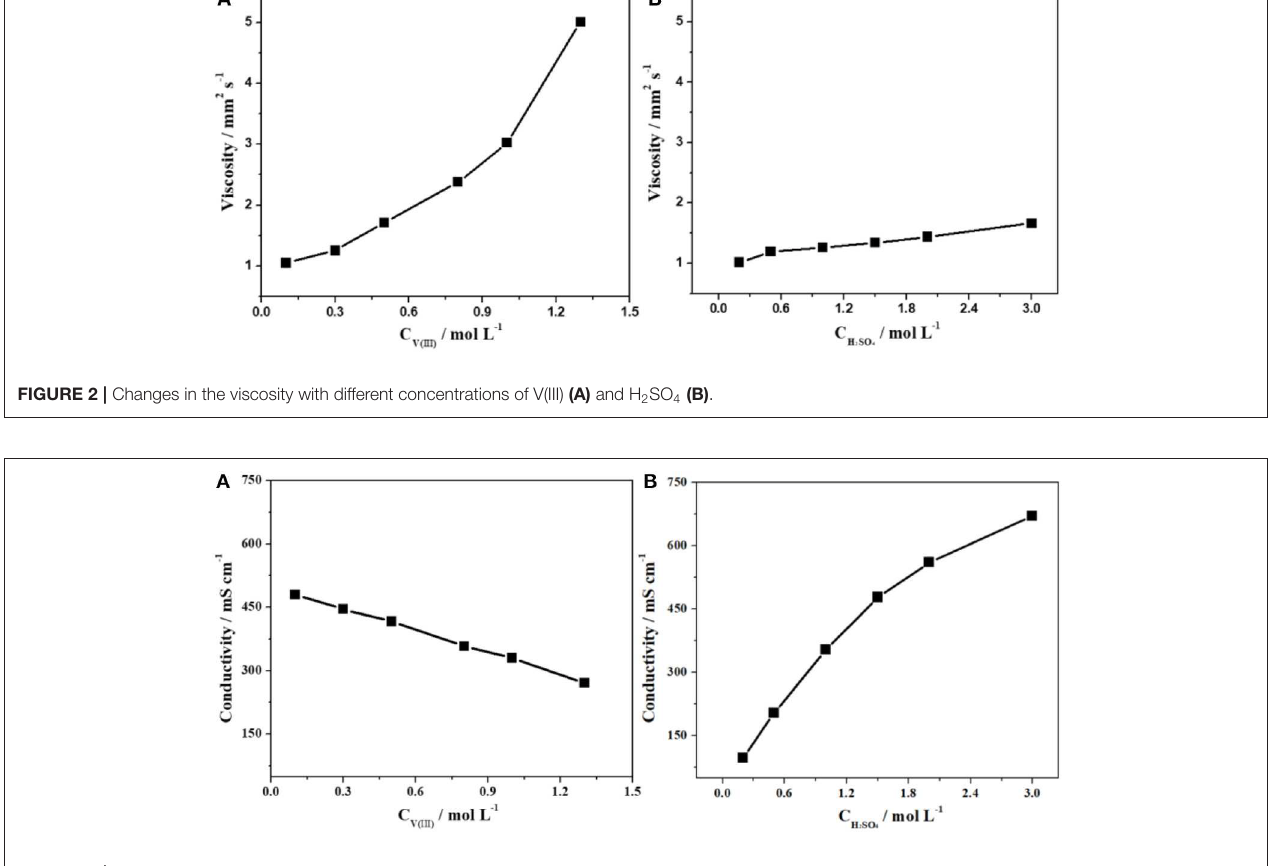
FIGURE 3 | Changes in conductivity with different concentrations of V(III) (A) and H 2 SO 4 (B) .